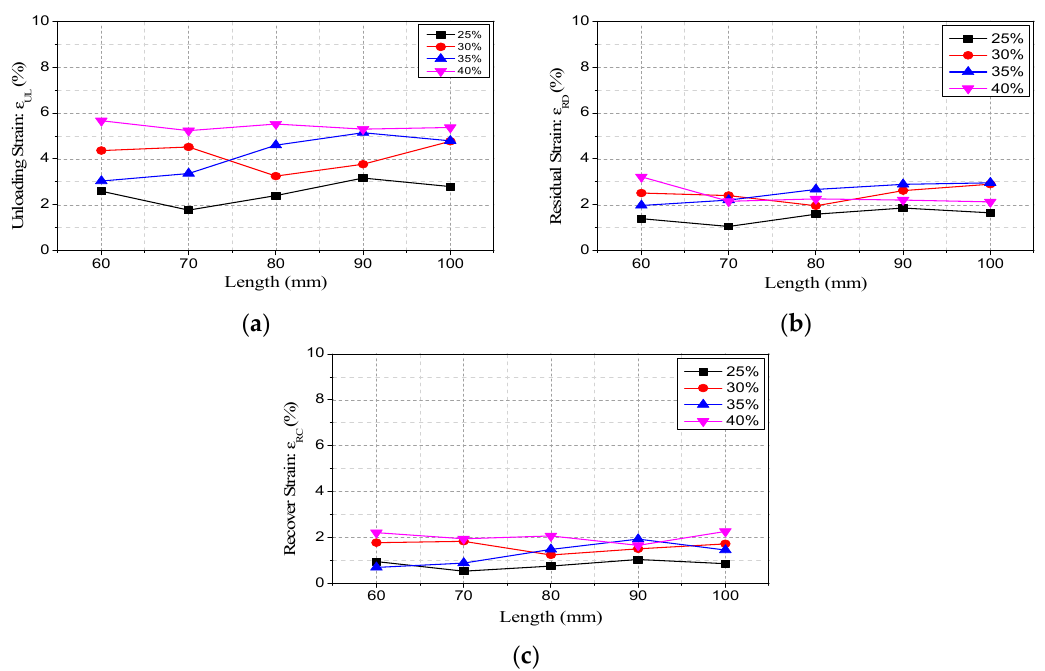
Figure 14. Behavior of three types of strain corresponding to each maximum strain in Type 2. ( a ) Unloading strain; ( b ) residual strain; ( c ) recover strain.